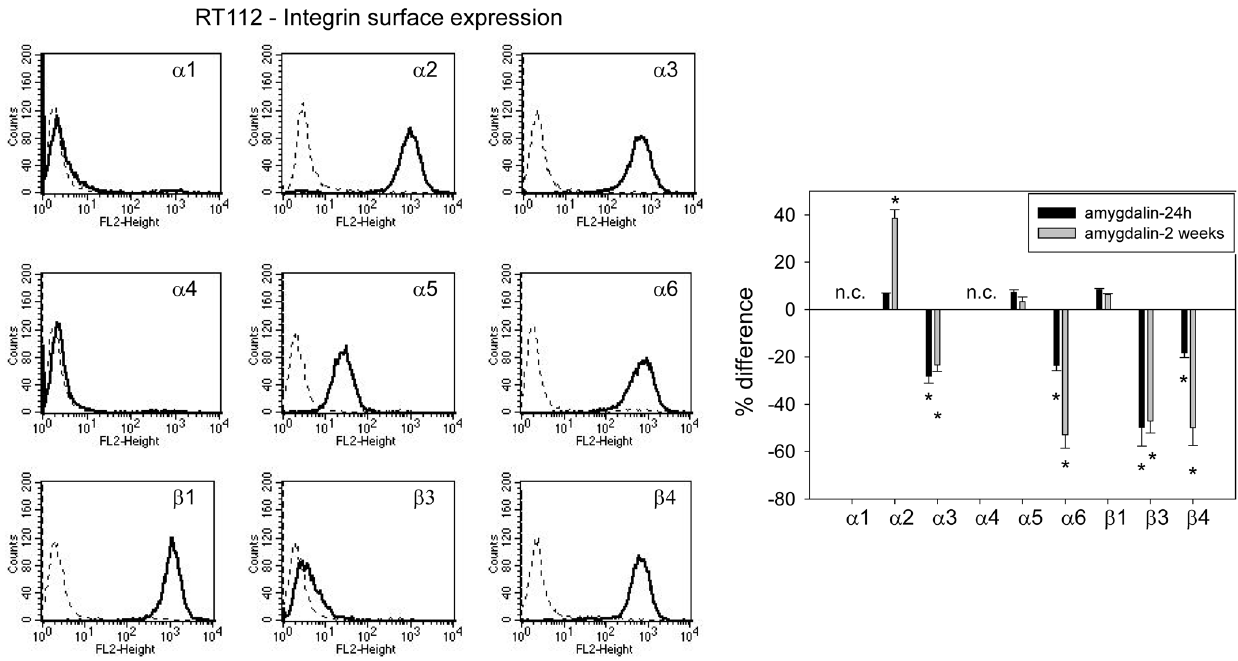
Figure 6. FACS analysis of integrin a and b subtype expression on RT112 cells. The left panel depicts integrin expression as histogram plots with a dotted line indicating background fluorescence and a solid line indicating specific fluorescence. The right panel shows integrin subtype expression after 24 h and 2 weeks amygdalin exposure, compared to controls set at 100%. n.c. = not calculated. * indicates significant difference to controls.